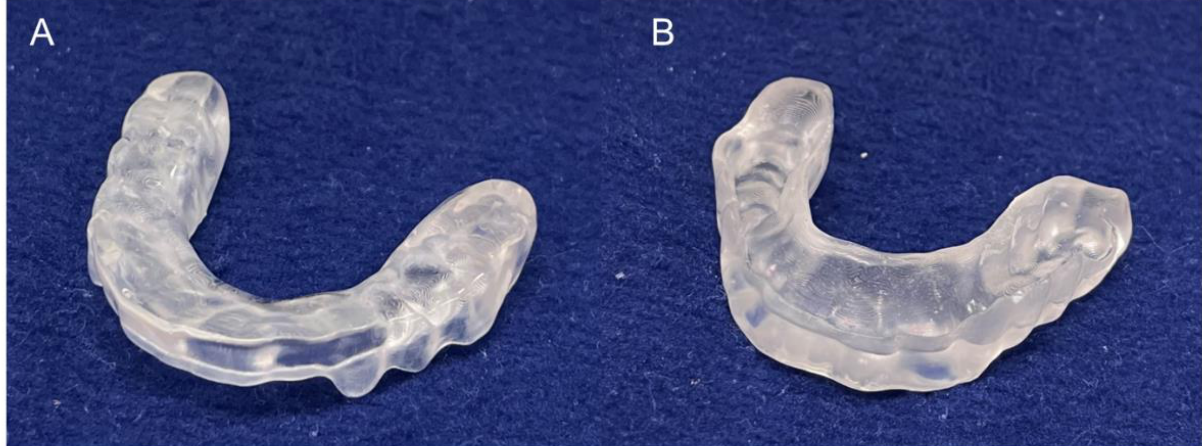
Figure 1. 3D-printed occlusal splint. ( A ): occlusal surface on which adjustment including polishing is frequently required, and ( B ): fitting surface on which adjustment is hardly